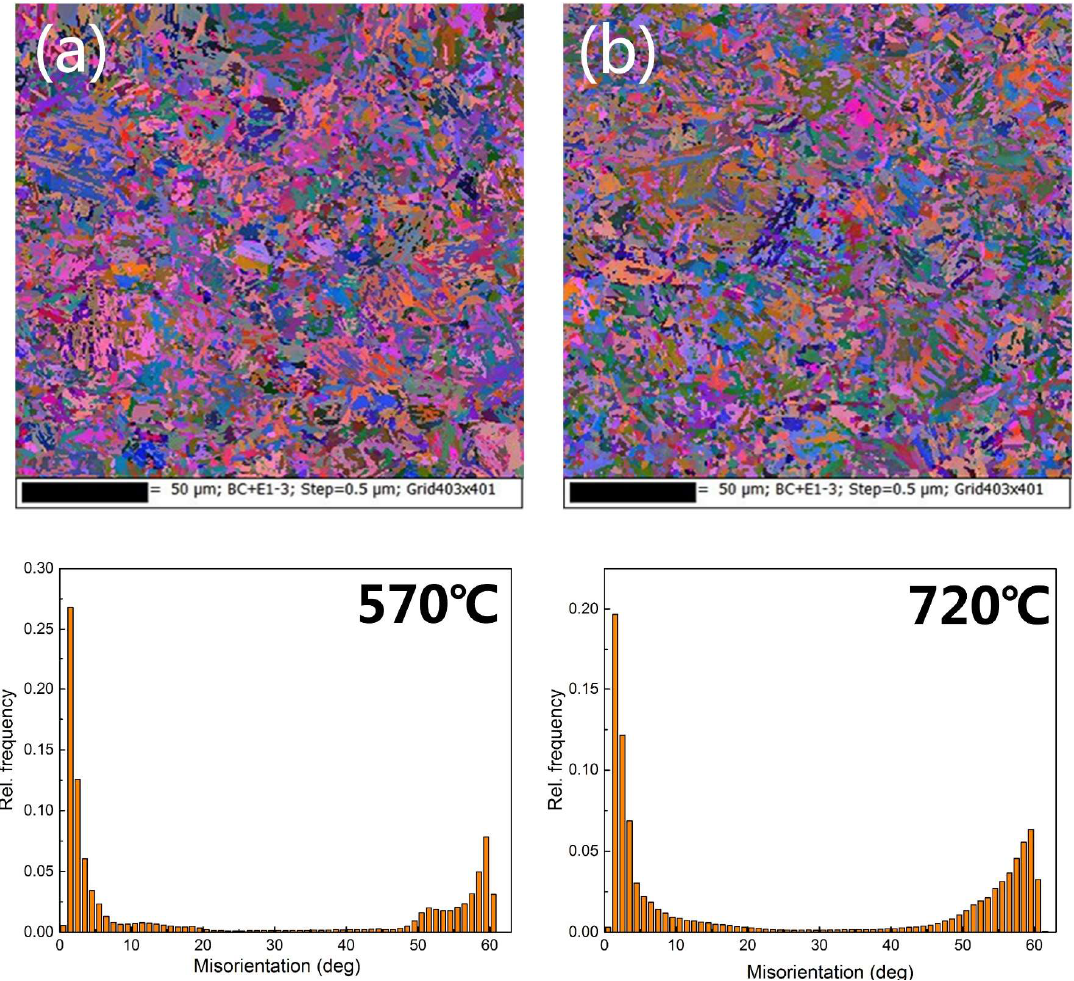
Figure 10. EBSD images and misorientations when tempered at: ( a ) 570 °C; ( b ) 720 °C.